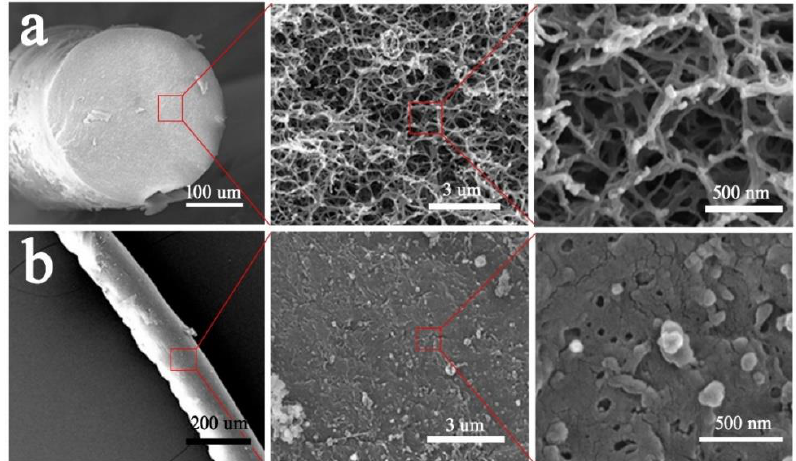
Figure 2. SEM images of ( a ) the cross-section and ( b ) the surface of the PAO@ANF symbiotic aerogel fibers with different magnification.